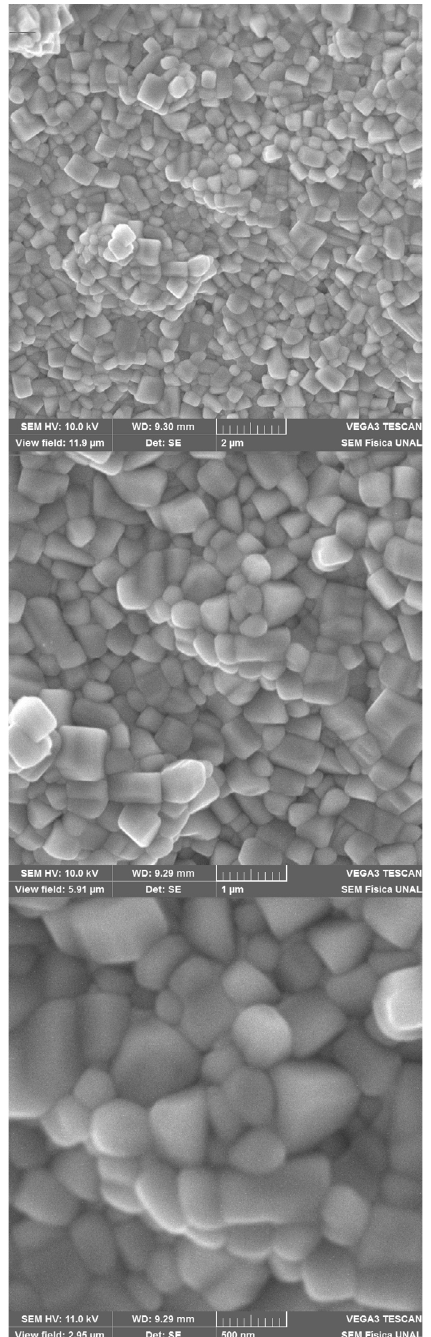
magnifications (a) 15000X, (b) 32500X and (c) 65000X.